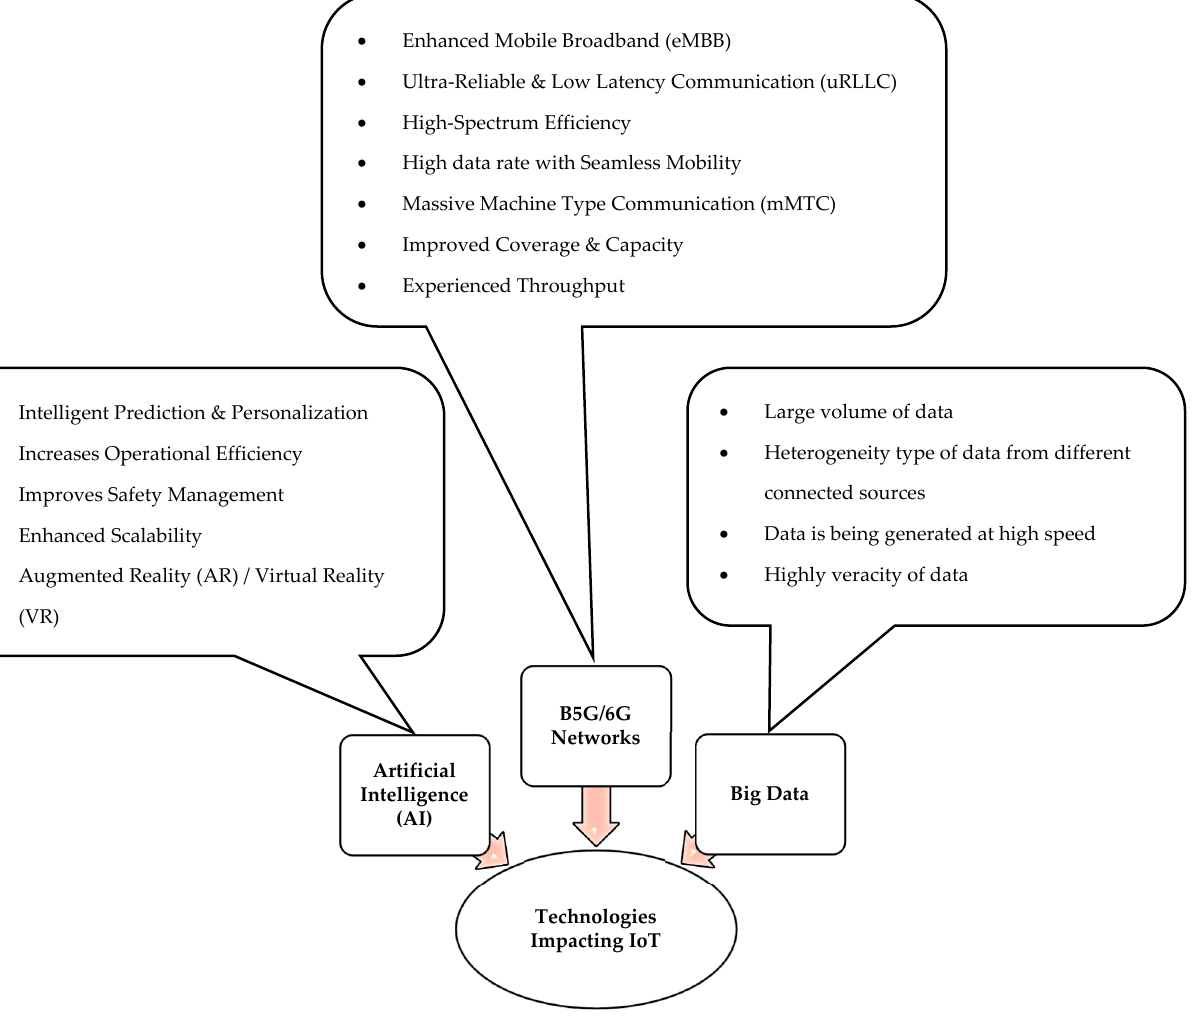
Figure 3. Technologies Impacting IoT.